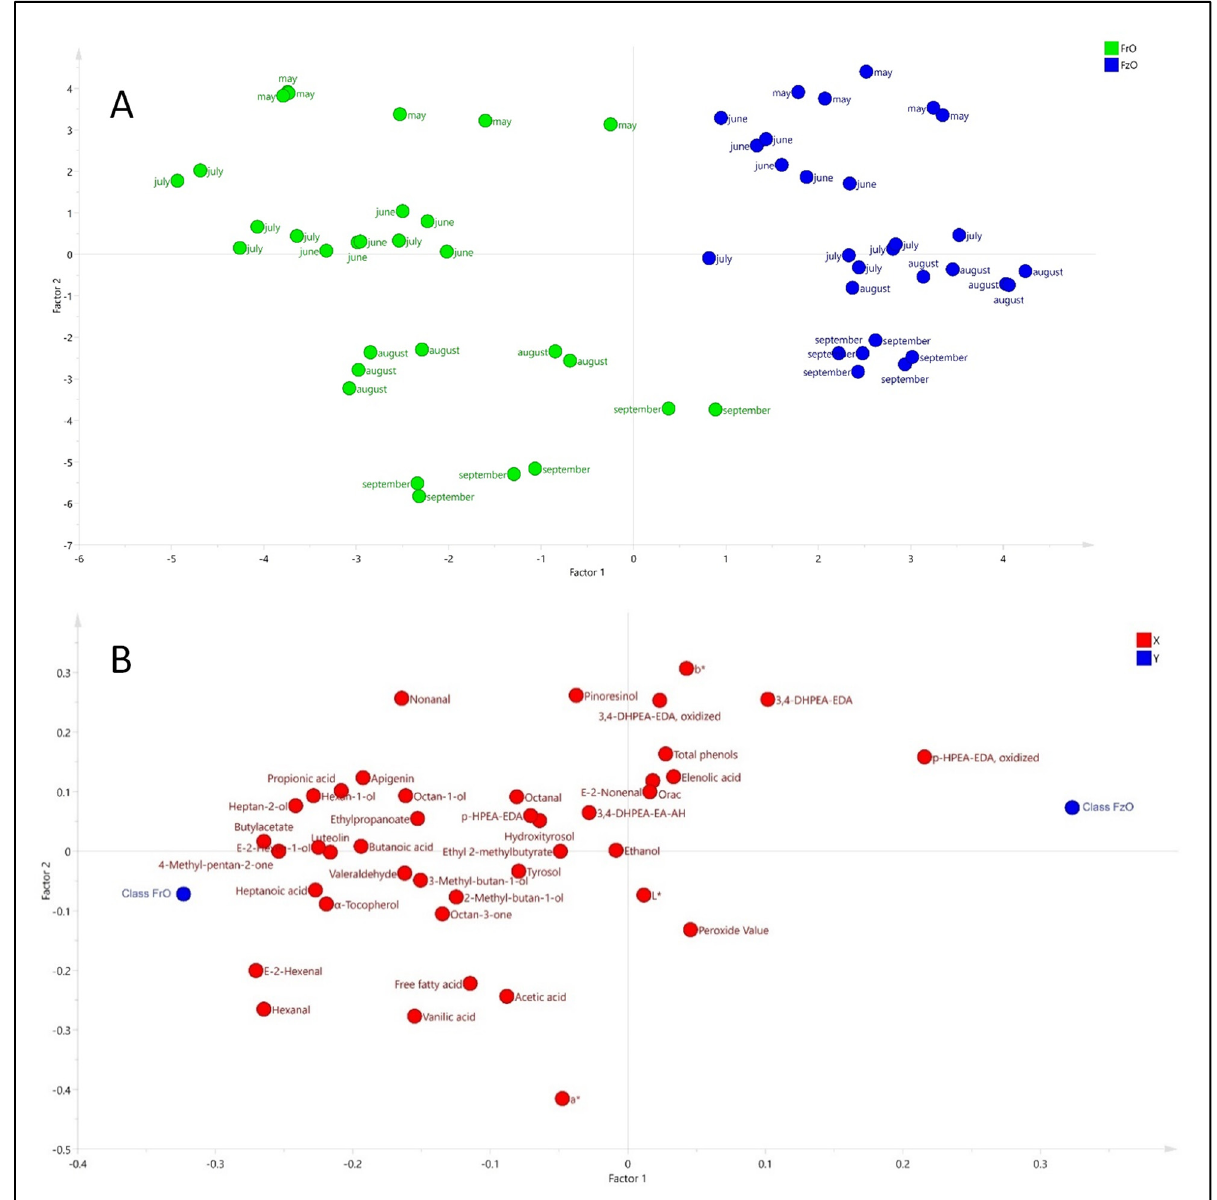
Figure 5. Results discrimination of partial least square (PLS-DA) analysis carried out on the selected variables to classify virgin olive oils from fresh (FrO) and frozen (FzO) olives ( A ) and the corresponding loadings plot ( B ).